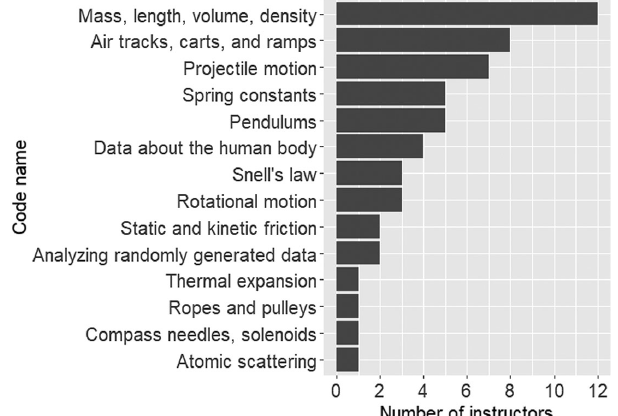
¼ 22 ) in which in- tot FIG. 8. The number of interviews ( N structors mentioned various types of lab activities involving measurement